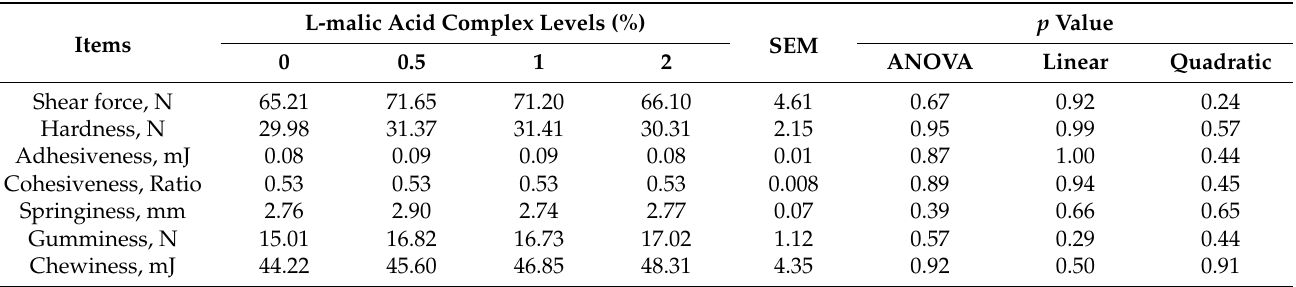
Table 5. Effects of dietary supplementation with L-malic acid on the LD muscle texture characteristics of finishing pigs ( n =